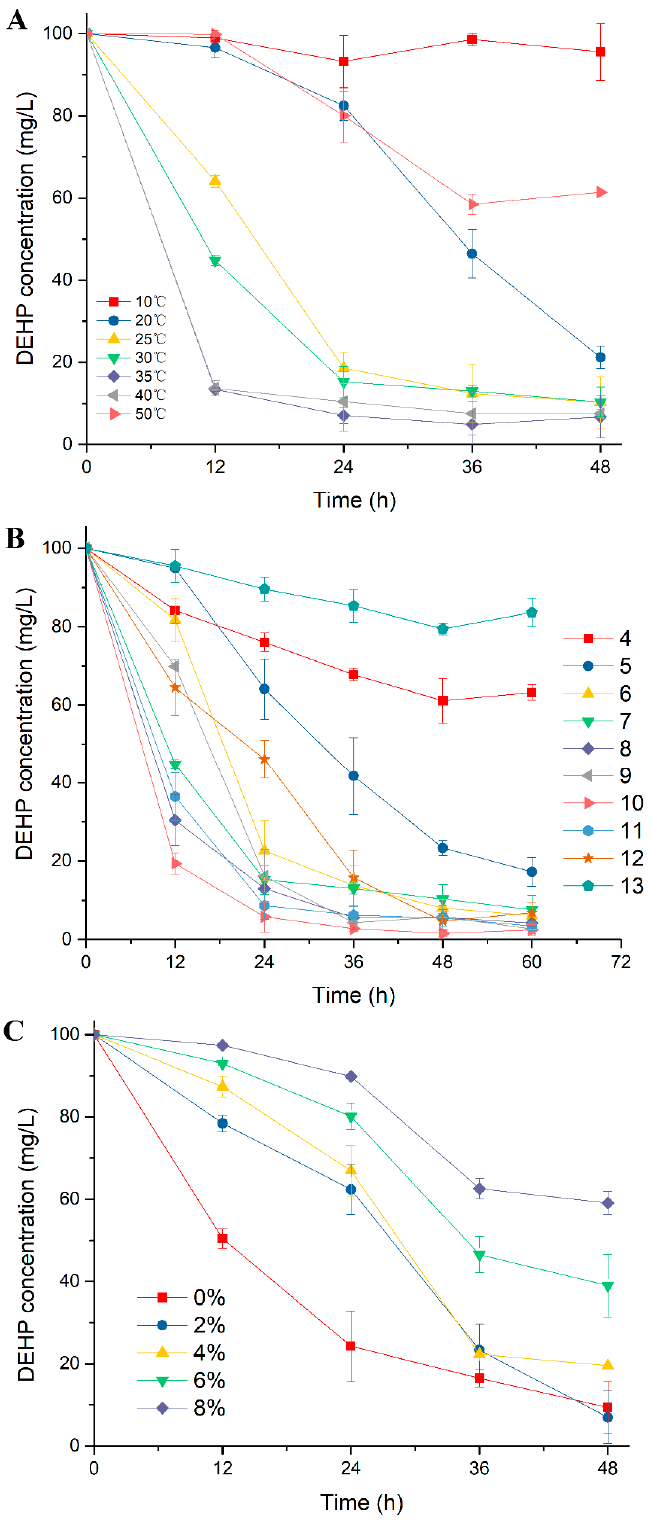
Figure 2. Degradation of di(2-ethylhexyl) phthalate (DEHP) by strain YC-JH1 under a wide range of temperature ( A ), pH ( B ), and concentration of NaCl ( C ).